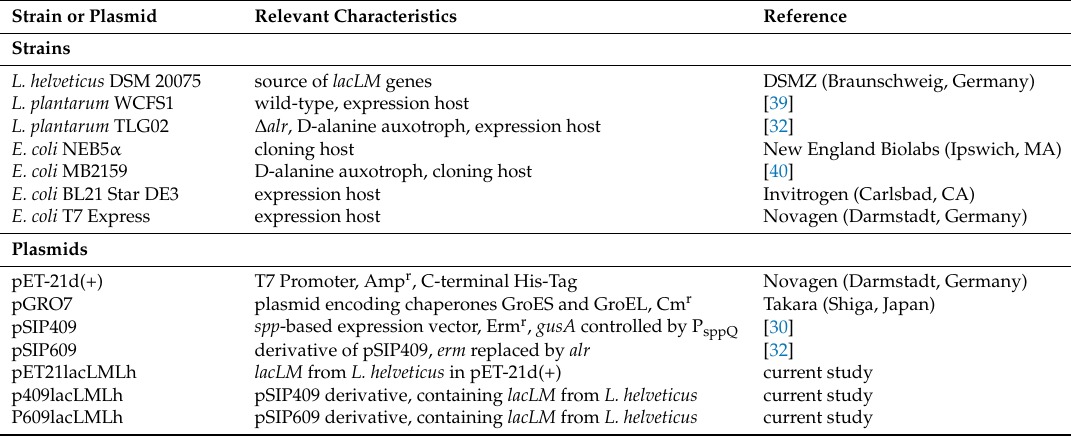
Table 4. Strains and plasmids used for cloning and overexpression of β -galactosidase encoding genes lacLM from L. helveticus a